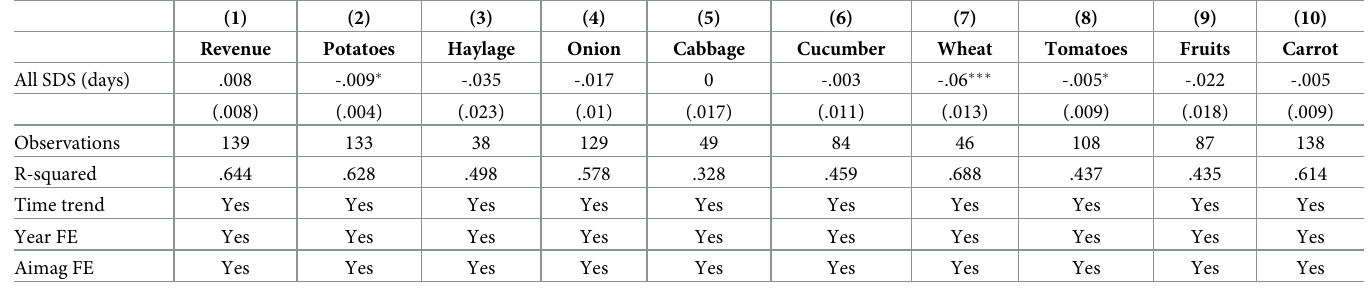
Table 3. Impact of SDS on revenues and production based on the baseline model.